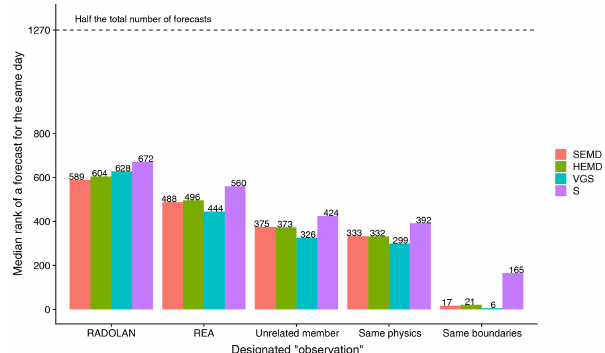
Figure 13. Median rank of the score obtained by the 20 ensemble members belonging to the same day as the observation among the set of all 2540 forecasts. From left to right, the designated “observa- tions” are RADOLAN, REA2, an ensemble member which shares neither boundary conditions nor physics settings with the forecast, an ensemble member which shares the physics settings, and an en- semble member which shares the boundary